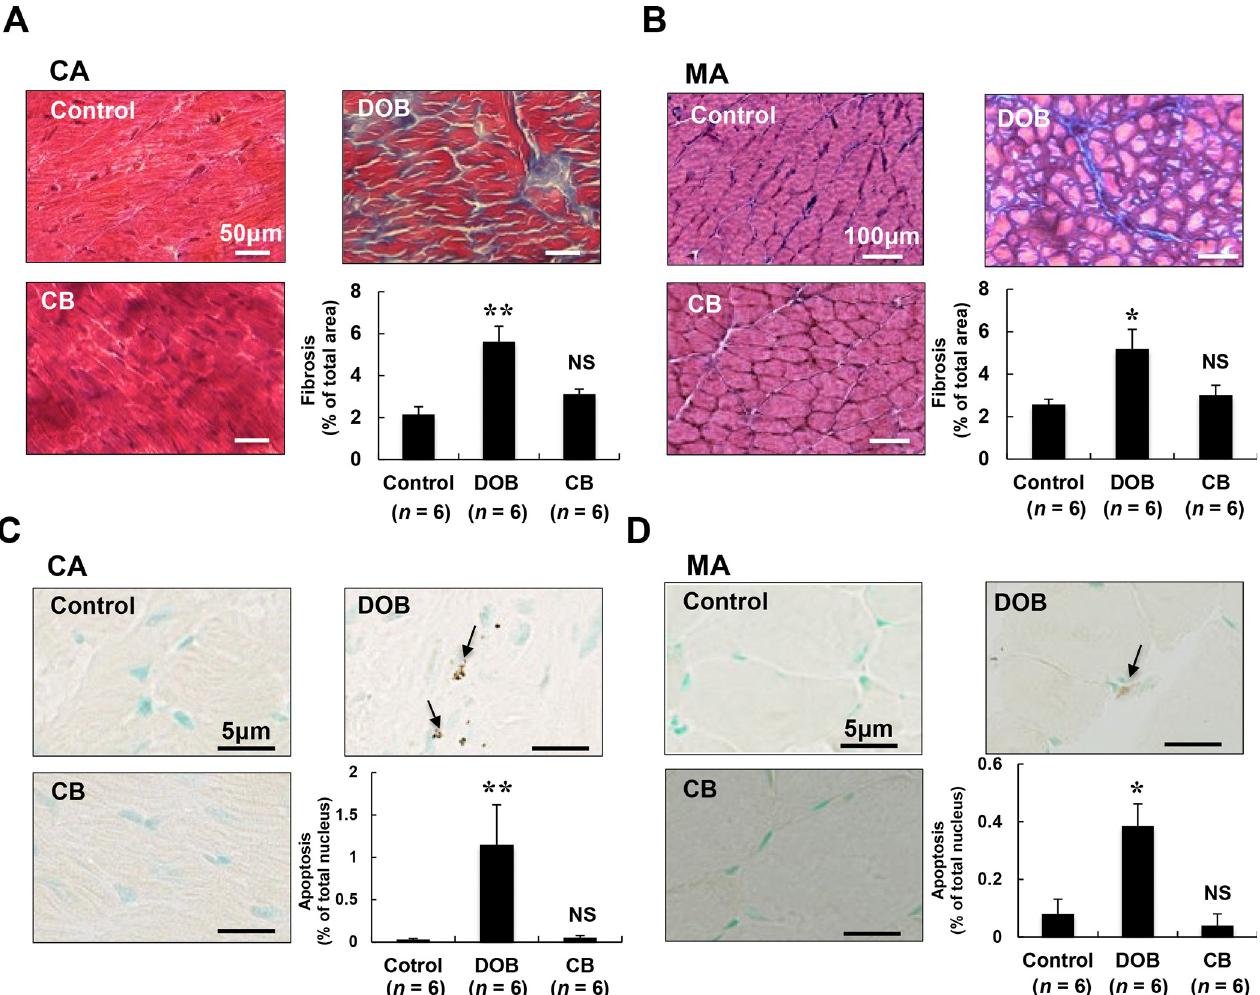
Fig 2. Effects of DOB and CB on fibrosis and apoptosis in cardiac and masseter muscles. (A-B) Representative images of Masson-trichrome-stained sections of cardiac muscle (A) and masseter muscle (B) in the Control ( upper left ), DOB ( upper right ) and CB ( lower left ) groups. The area of fibrosis was significantly increased in both the DOB-treated cardiac (A) and masseter (B) muscle ( � P < 0.05, �� P < 0.01 vs. Control), but not in the CB-treated cardiac (A) or masseter (B) muscle ( lower right ). Scale bars: 50 μ m (A) and 100 μ m (B) . (C-D) Representative images of TUNEL-stained sections of cardiac muscle (C) and masseter muscle (D) in the Control ( upper left ), DOB ( upper right ) and CB ( lower left ) groups. TUNEL-positive nuclei (black arrows) were counted in cardiac muscle (C) and masseter muscle (D) after 1 week of DOB or CB infusion and expressed as percentage of total myocytes ( lower right ). The number of TUNEL- positive nuclei was significantly increased in both the DOB-treated cardiac muscle ( �� P < 0.01 vs. Control) and masseter muscle ( � P < 0.05 vs. Control), but not in the CB-treated cardiac or masseter muscle. Scale bars: 5 μ m (C) and (D) . CA; cardiac muscle, MA; masseter